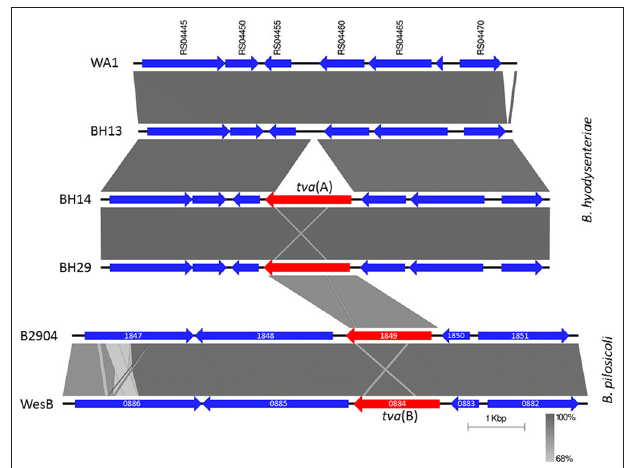
FIGURE 2 | Chromosomal arrangement of genes in Brachyspira hyodysenteriae and Brachyspira pilosicoli surrounding tva (A) and tva (B) respectively. B. hyodysenteriae genes labelled according to the locus tag in the reference strain WA1 (Accession number NC_012225); tva (A) is not present in WA1 and therefore has no locus tag. Genes have been coloured to indicate tva (A) and tva (B) in red and other genes in blue. WA1 and BH13 were tiamulin susceptible (MIC ≤ 0.063 mg/L). Field isolates BH14 and BH29 were recovered from different holdings, harboured tva (A) and had intermediate tiamulin MICs (0.5 mg/L). Also shown is the region surrounding tva (B) from B. pilosicoli isolates B2904 (Accession number CP003490; locus tag B2904_orf1849) and WesB (Accession number HE793032; locus tag WESB_0884); other genes labelled according to their locus tags. Regions of homology between isolates are shown by grey shading. Image generated using EasyFig (Sullivan et al.,